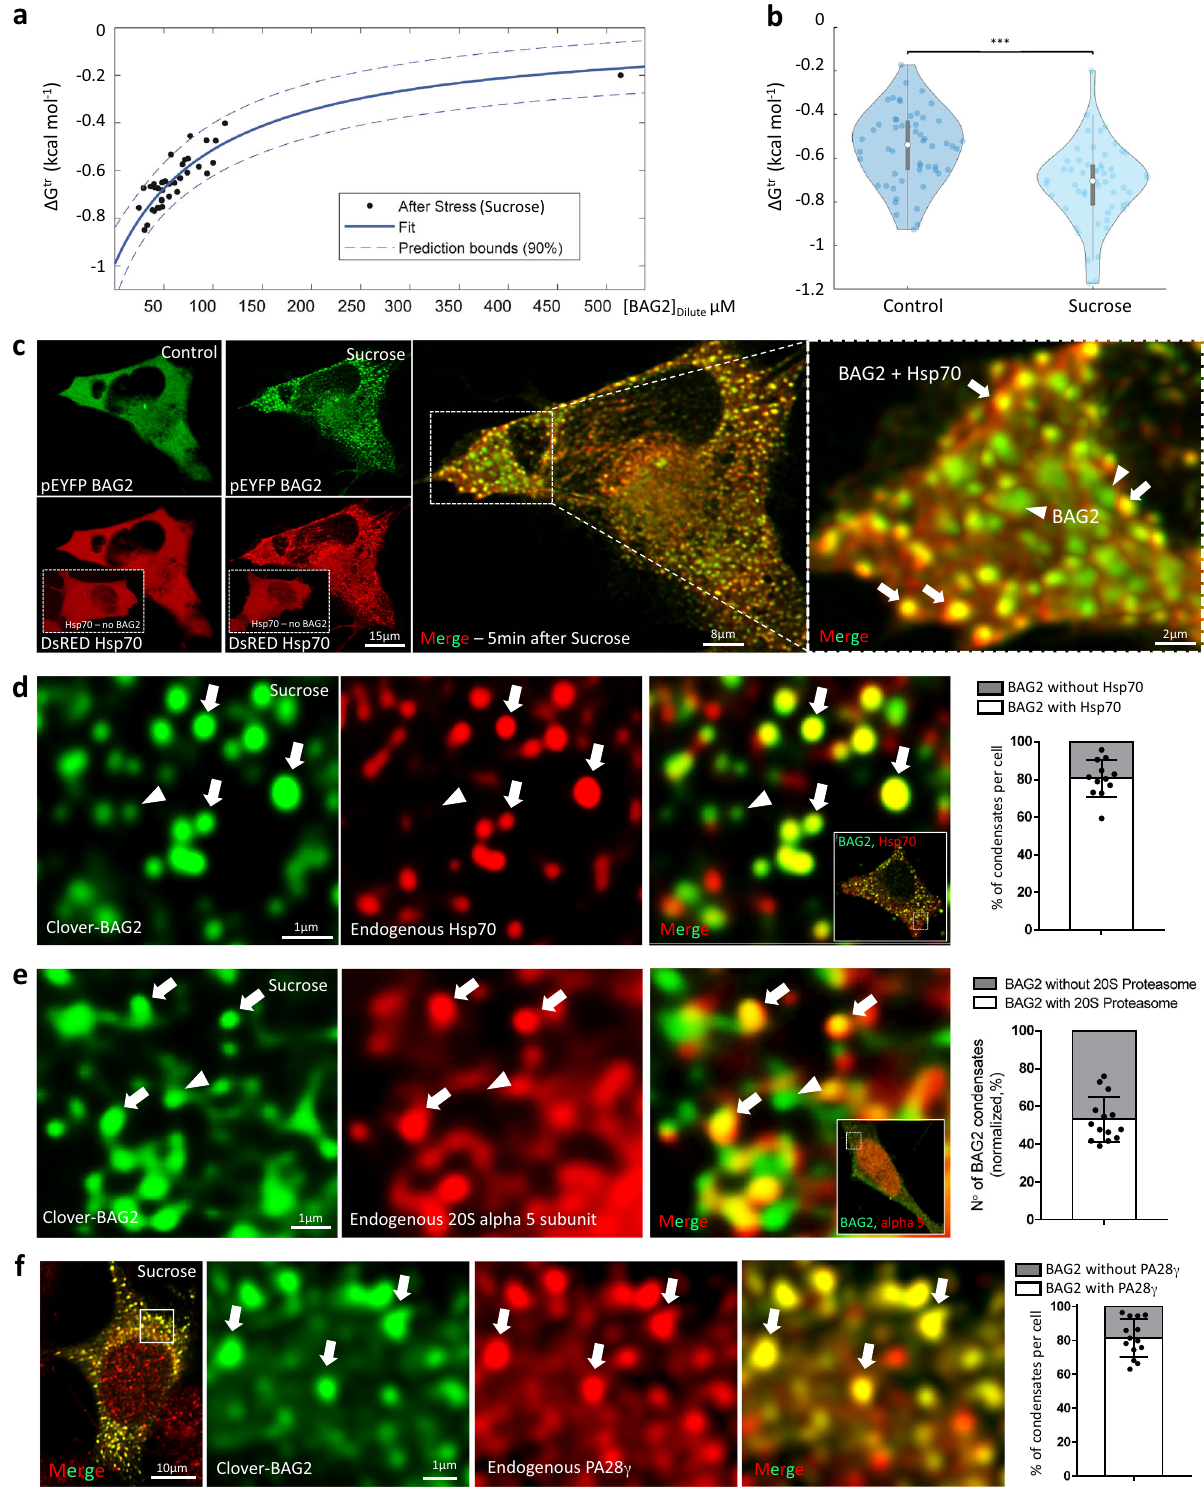
BAG2 molecule and its function as an inhibitor of the ubiquitin E3 ligase CHIP 7 suggest that BAG2 condensates degrade proteins independently of ubiquitin. To validate this hypothesis, clover- BAG2 stable cells were subjected to hyperosmotic stress (30 min) and stained for endogenous ubiquitin-K48 antibody 29 . Less than 20% of the BAG2 condensates were co-localized with ubiquitin-